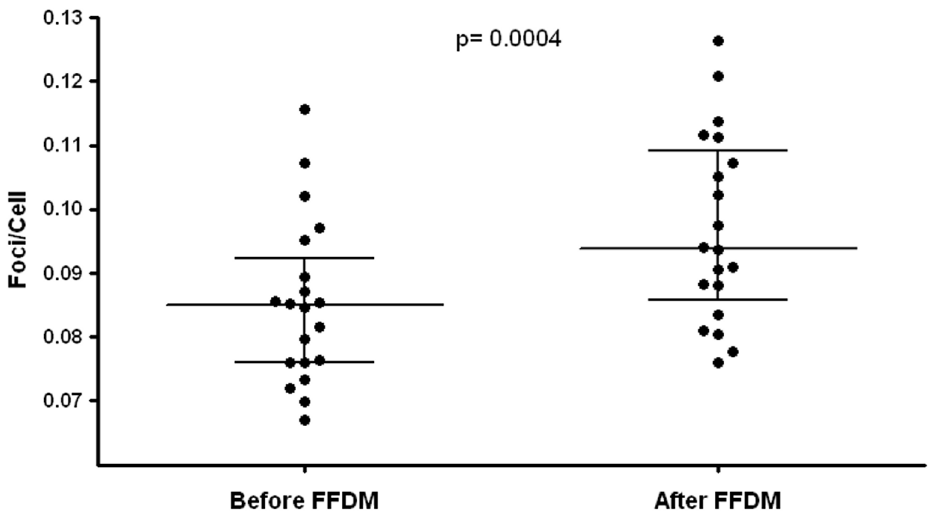
Figure 3. In-vivo c -H2AX foci/cell representing DNA damages in systemic blood lymphocytes of patients (n=20) before (left) and after (right) two view full field digital mammography (FFDM) of both breasts. Dots show individual values of each patient, the middle horizontal line represents the median, and the error bars indicate the interquartile ranges. A p value is shown, p , 0.05 was considered statistically significant.